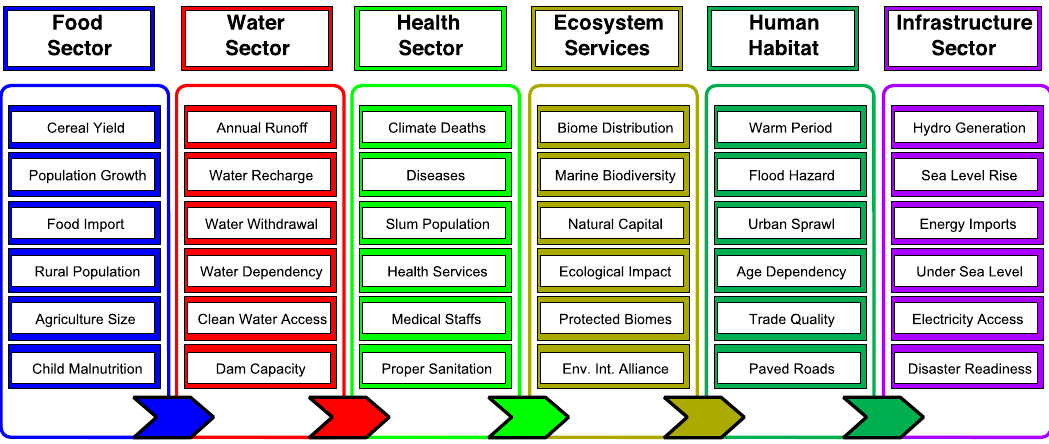
Fig. 1 Conceptual framework of sectoral vulnerabilities to climate change and its impacts. Source: Authors ’ construction based on ND-GAIN, 2018 indicators. The fi rst two rows of each column designate climate exposure, the third and fourth rows represent climate change sensitivity whereas the fi fth and sixth rows denote